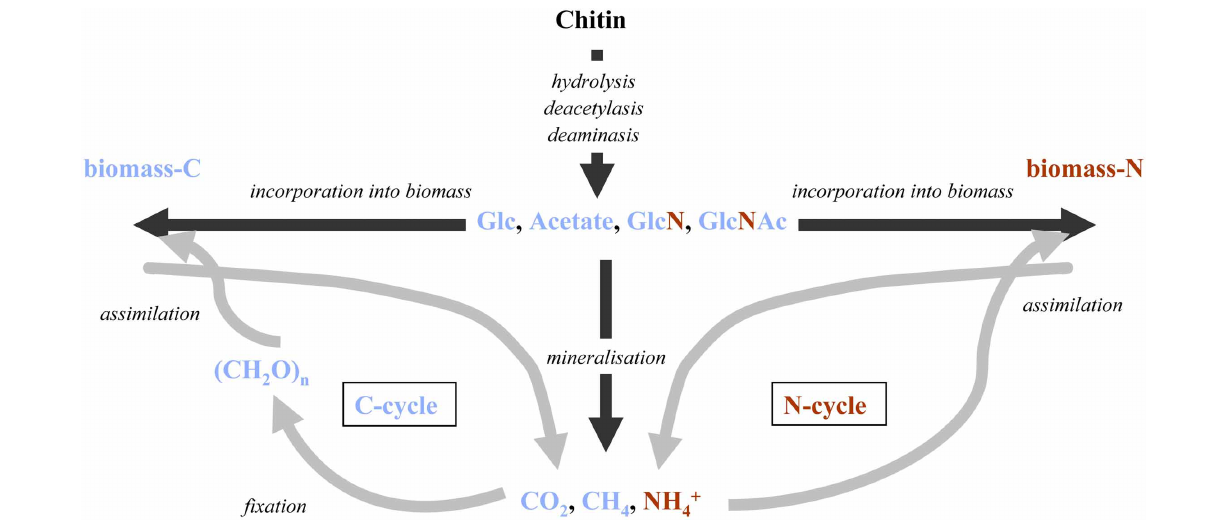
organic molecules that can directly be reintegrated into cell material or mineralized and potentially removed from the system. GlcNAc, N-acetylglucosamine; GlcN, glucosamine; Glc: